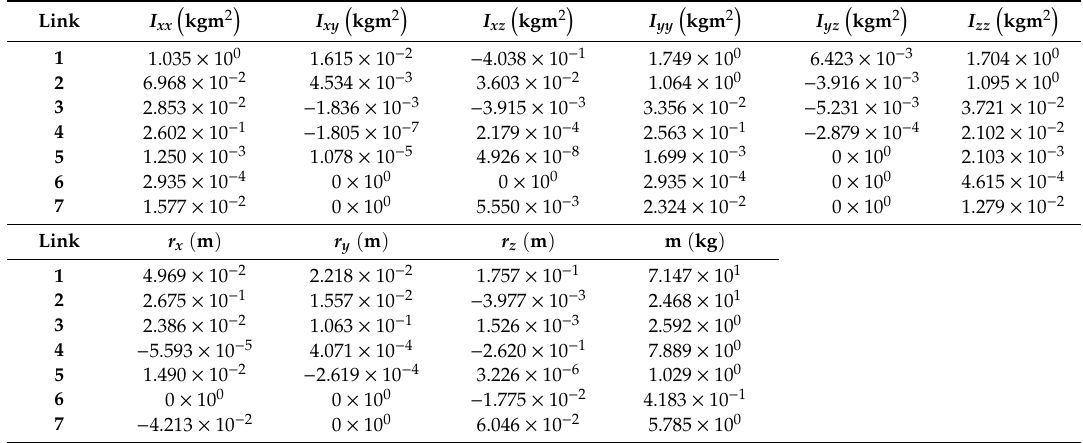
Table 2. Inertial parameters for the 6-DoF robot.